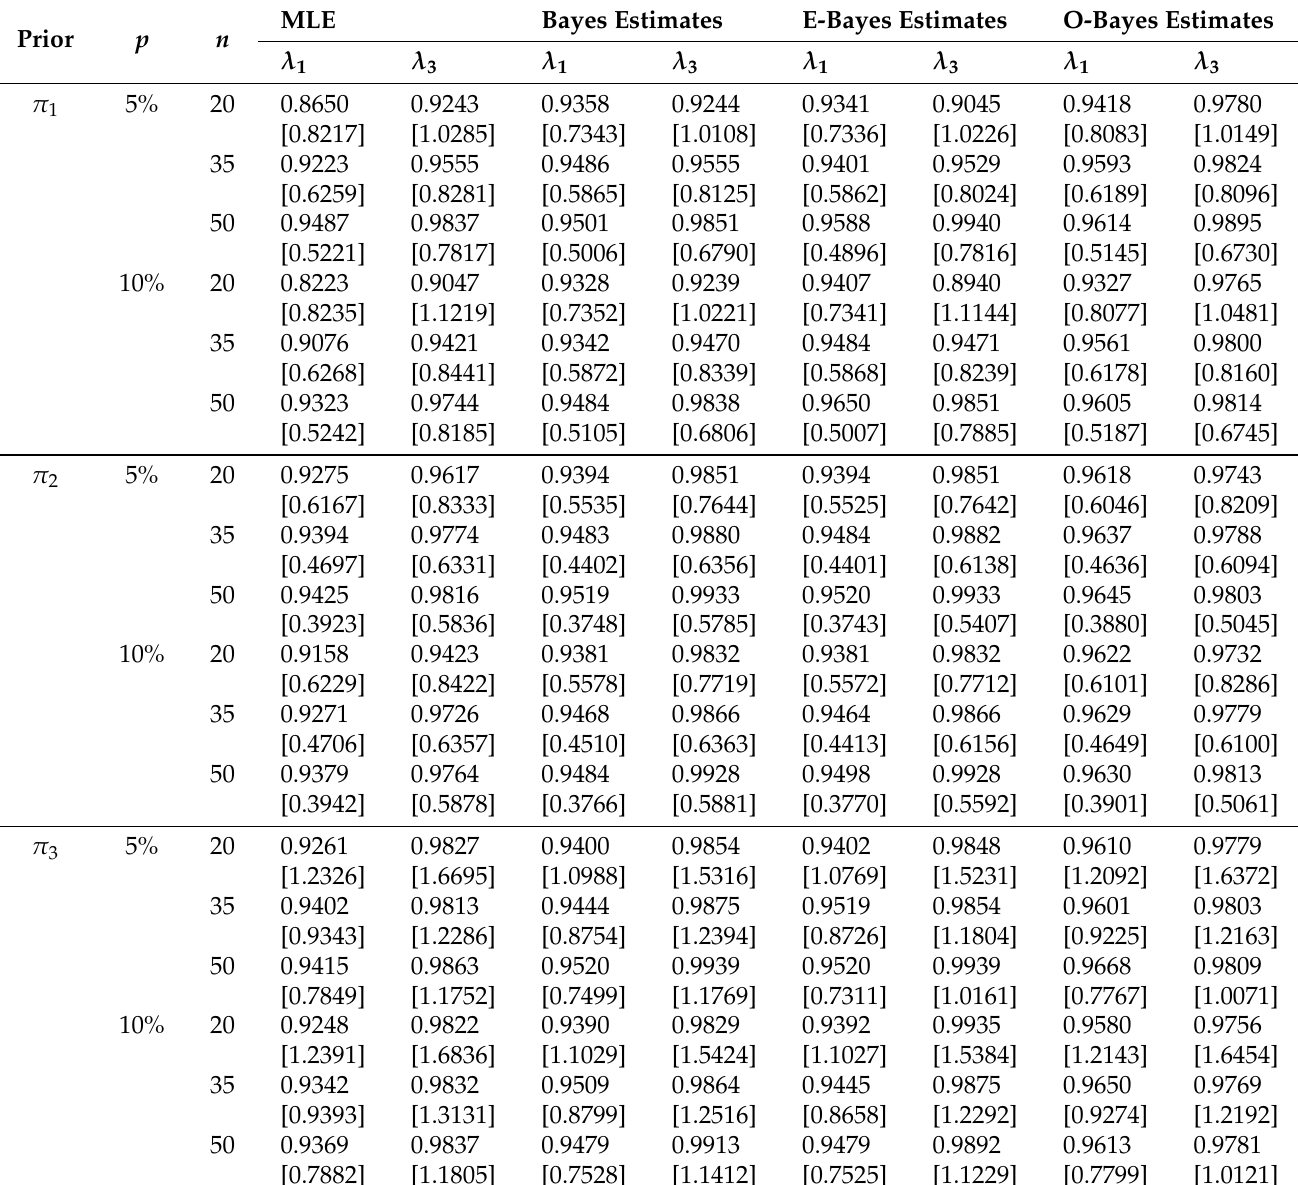
Table 2. CPs and ALs (within bracket) for MOBE competing risks parameters with ( c 1 , c 2 , c 3 ) = ( 2,2.5,1.5 ) and τ = R